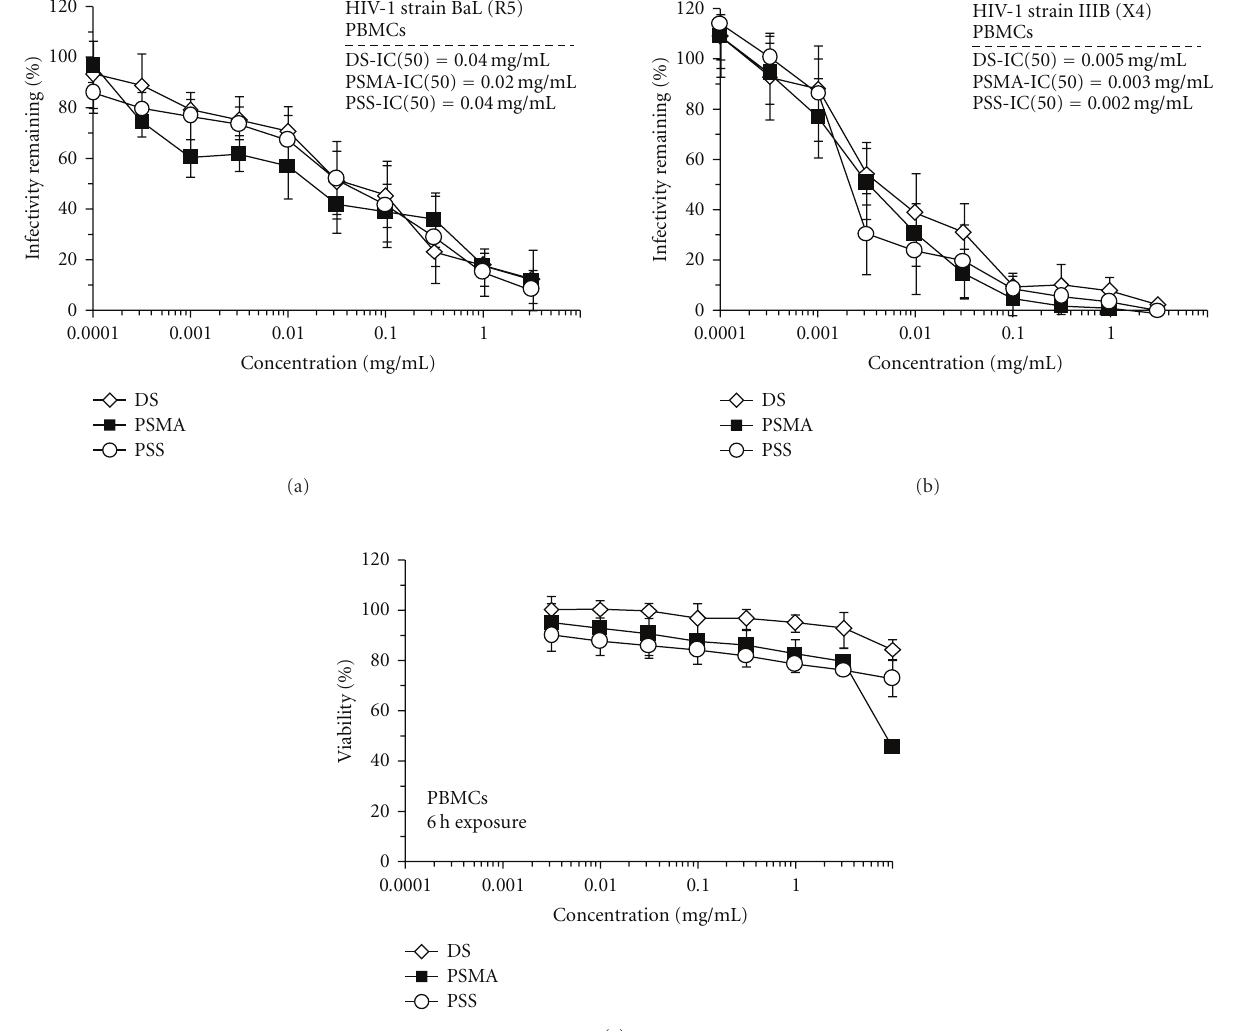
Figure 5: alt -PSMA e ff ectively inhibits infection of primary human immune cells by HIV-1 strains BaL and IIIB. PBMCs were incubated for 6h with HIV-1 strains (a) BaL or (b) IIIB in the absence or presence of alt -PSMA, PSS, or DS (as described in Section 2). Infectivity remaining is expressed relative to mock-treated, HIV-1-infected cells. Each concentration was examined in triplicate in two independent assays. (c) PBMCs were exposed (or mock exposed) to the indicated concentrations of alt -PSMA, PSS, or DS for 6h. Following the exposure period, cells were washed and assessed for viability using an MTS assay (as described in Section 2). Results illustrated are from two independent assays in which each concentration was examined in